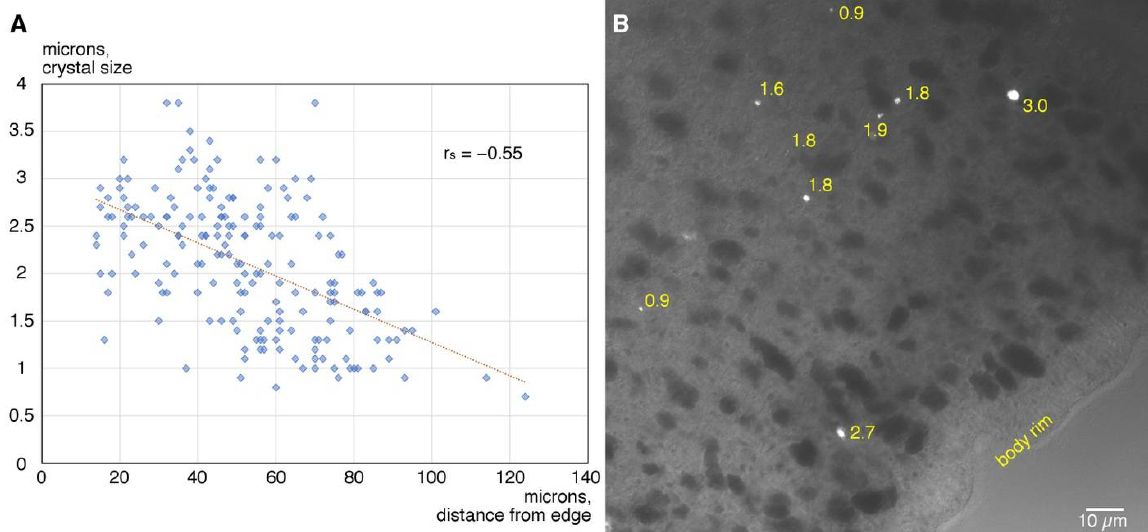
Figure 2. Distance from the rim of the animal of crystals of different size. ( A )—dot plot showing individual crystal sizes at varying distances from the rim (blue semi-transparent diamonds; N crystals = 189; N animals = 8) and linear trend line (red). ( B )—DIC image of marginal zone of Trichoplax body showing a group of crystals; size of each crystal is indicated in microns. Smaller crystals lie deeper while larger crystals lie closer to the periphery.